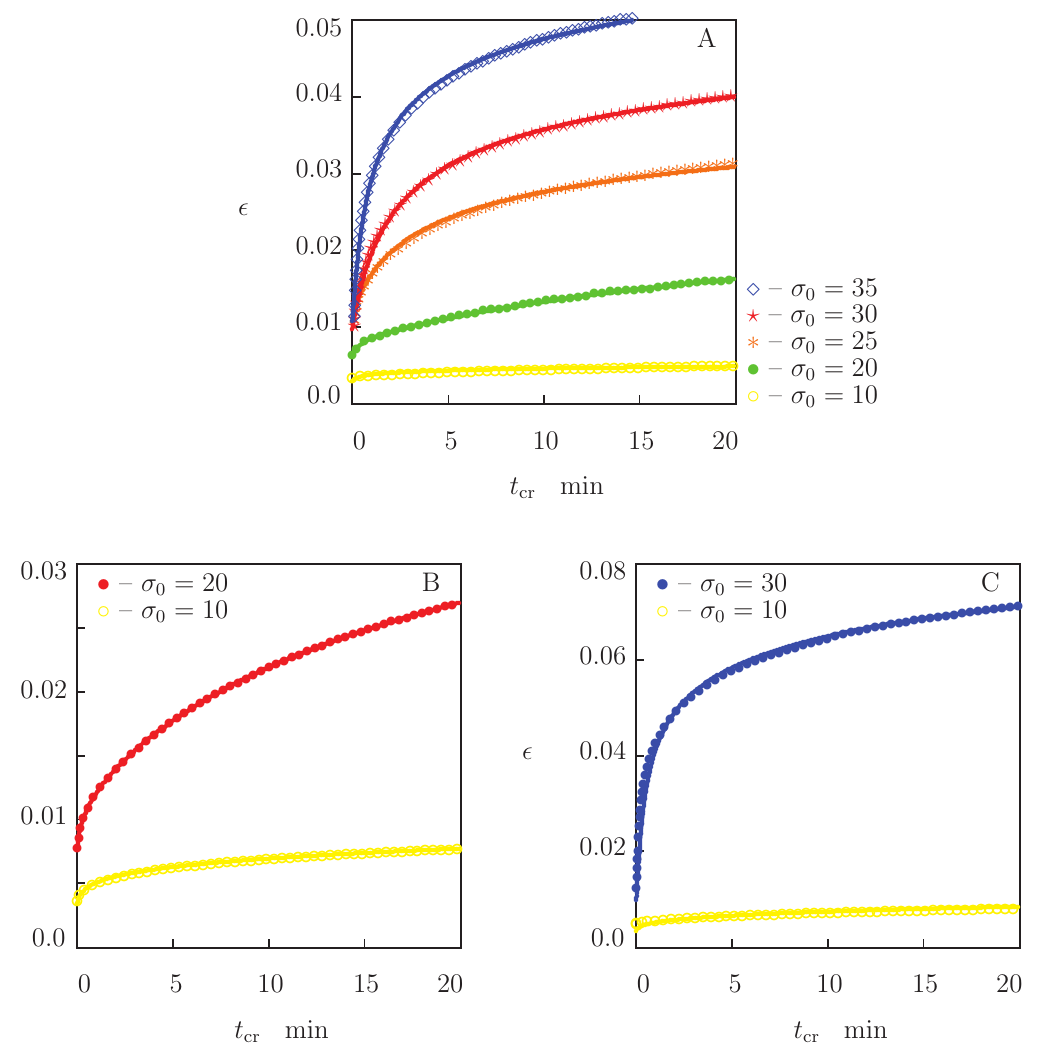
Figure 6. Strain (cid:101) versus creep time t cr . Circles: experimental data in creep tests with various stresses σ 0 MPa at temperatures T = 160 ◦ C ( A ), T = 170 ◦ C ( B ) and T = 180 ◦ C ( C ). Solid lines: results of